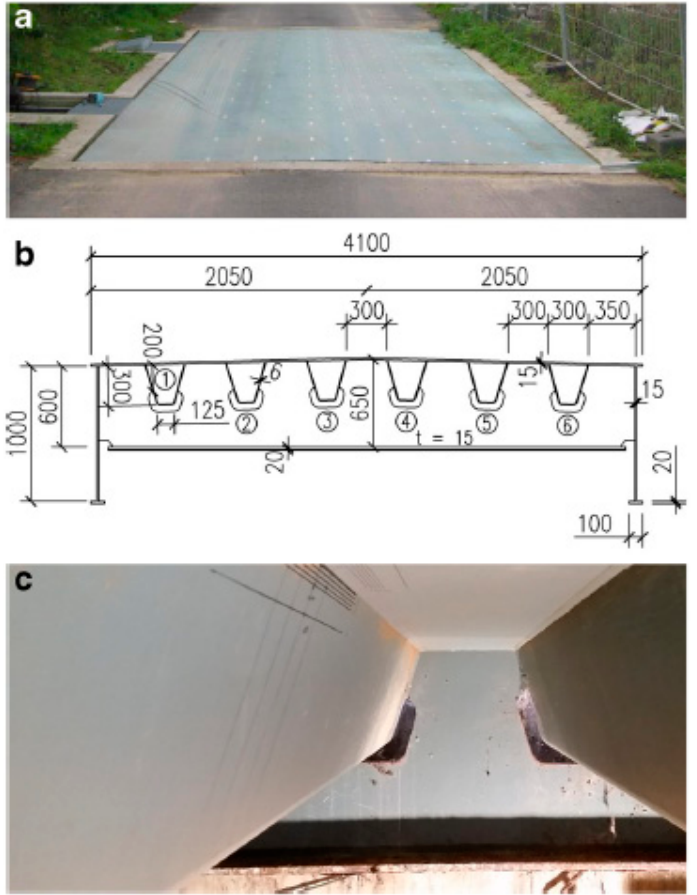
Figure 10. Full scale test specimen ( a ) top view; ( b ) cross section; ( c ) bottom view between two longitudinal stiffeners.